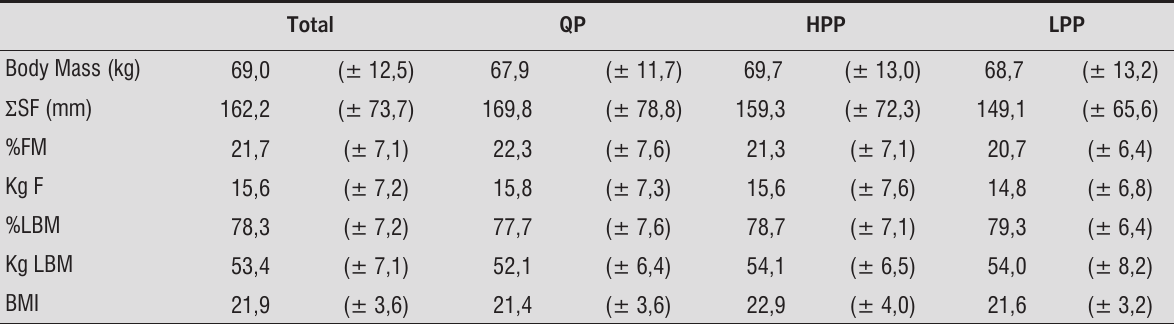
Table 2 – Results of the body evaluation in the group and